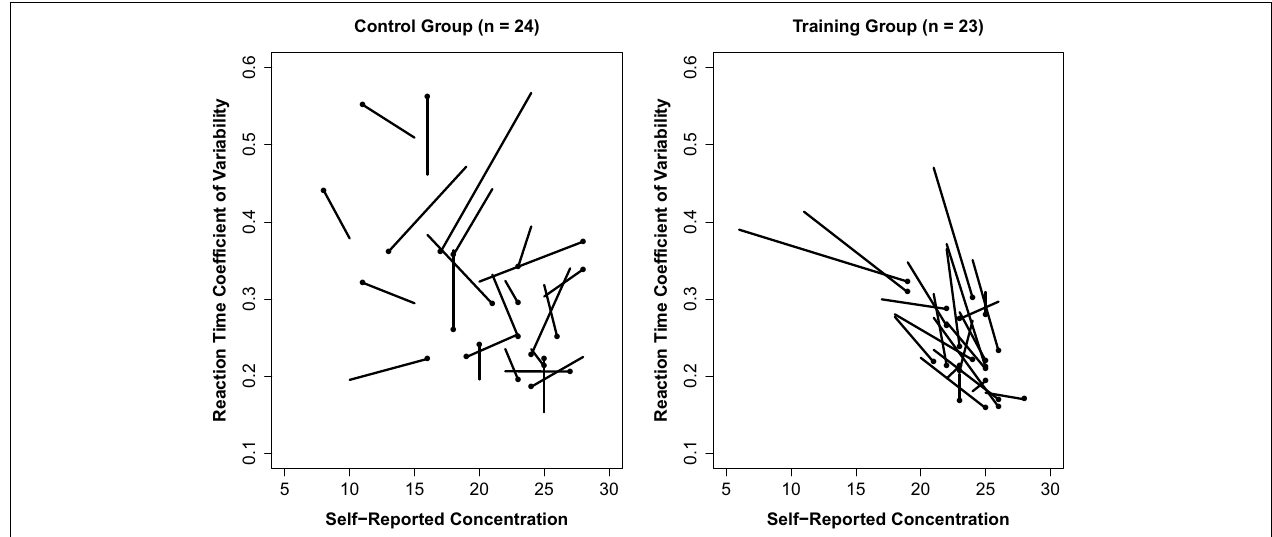
FIGURE 2 | Plot of change across pre- and post-assessments for reaction time variability and concentration for training and control group participants. Each vector represents the trajectory from pre- to post-assessment scores for a given individual. Post-assessment scores are represented by a dot. Thus, each vector represents the direction and magnitude of change in these variables for each